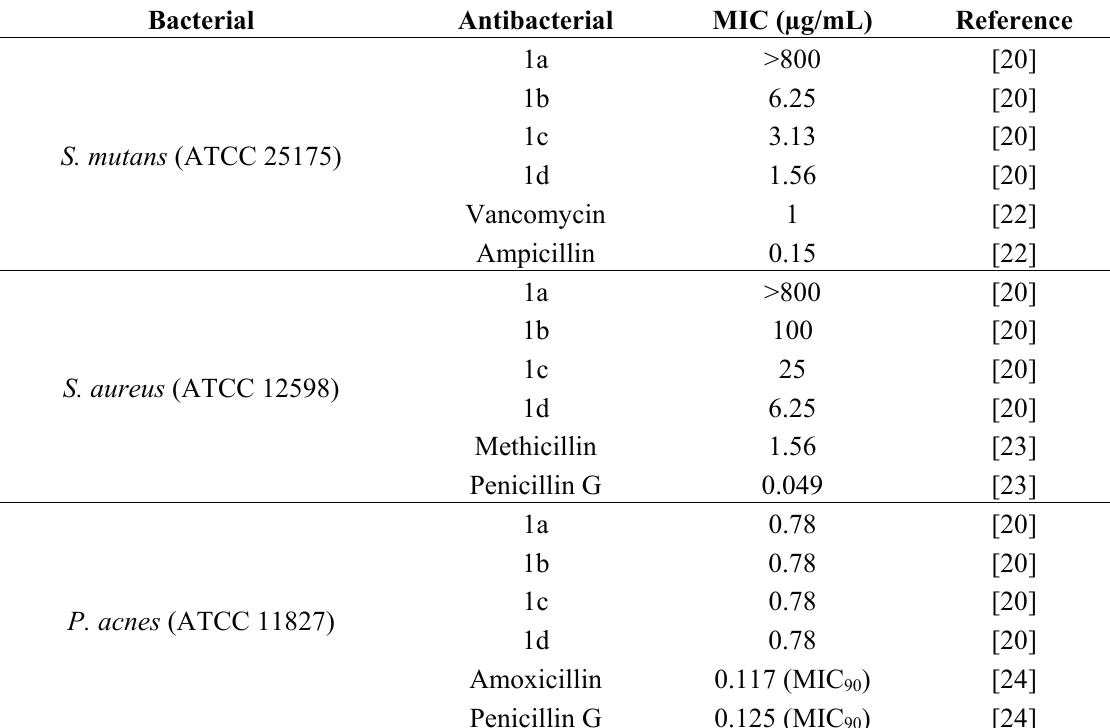
Table 1. The minimum inhibition concentrations (MIC) of natural anacardic acids ( 1a – d ) compared with some common standard